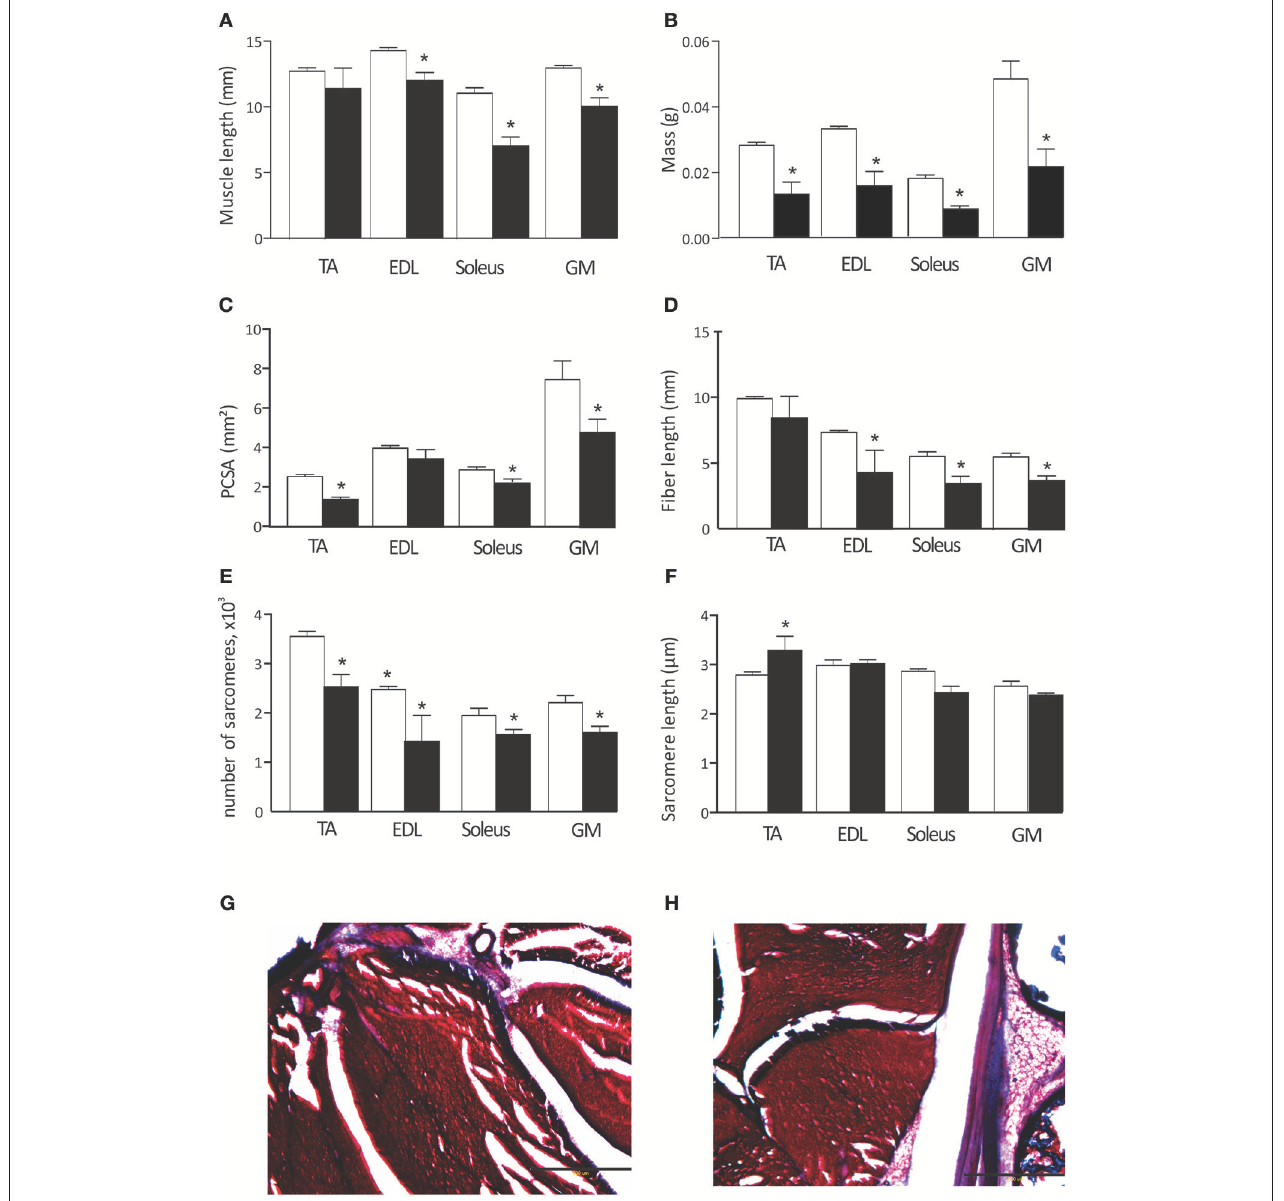
FIGURE 2 | Muscle properties in control and hypertonic kits after antenatal H-I: Muscle length (A) , muscle wet mass (B) , physiological cross-sectional area (PCSA, C ),muscle fiber length (D) , number of sarcomeres (E) , and sarcomere length (F) . Hind limbs were fixed in neutral position and dissected out. Masson trichrome staining on ankle muscles in control (G) and hypertonic (H) P1 kits, limb cross section: red–muscle fibers, blue–collagen and bone. TA, m. tibialis anterior; EDL, m. extensor digitorum longus; GM, m.gastrocnemius medius. Scale bar on (G,H) 500 microns. * p <